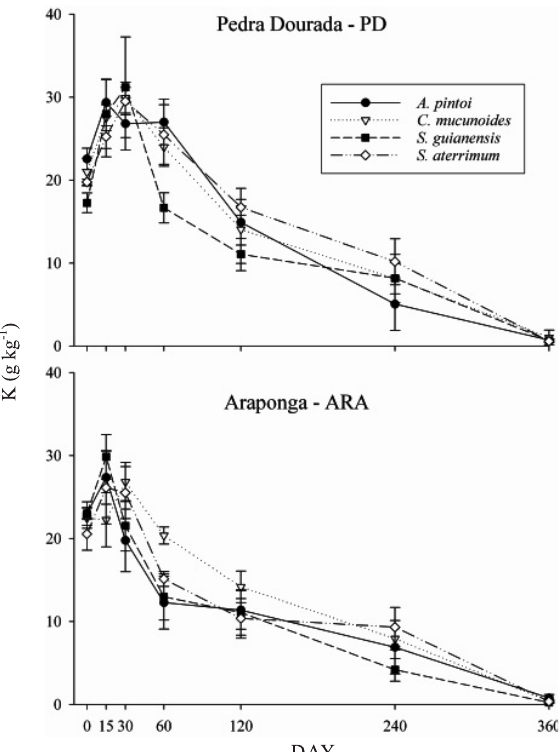
Figure 3. Potassium concentration of different leguminous plants, in 360 days in Pedra Dourada and Araponga municipalities. Vertical bars represent standard error (n = 4).